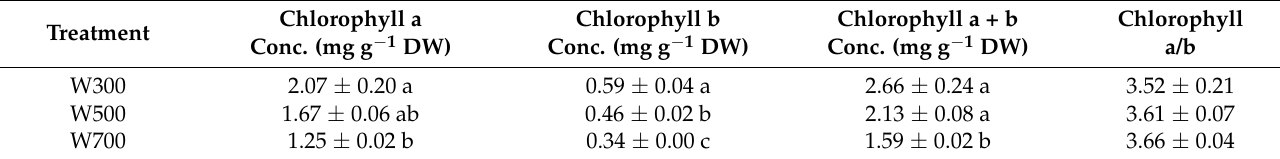
Table 5. Effect of PPFD on chlorophyll concentration (conc.) of leaves in ‘Micro-Tom’ 10 DAT in Experiment 1. DW (g) is dry weight. Each value represents the mean ± standard error. Different letters in a column indicate significant differences among the treatments based on Tukey − Kramer’s test at the p < 0.05 ( n = 4). W300, W500, and W700 denote 300, 500, and 700 µ mol m − 2 s − 1 PPFD,